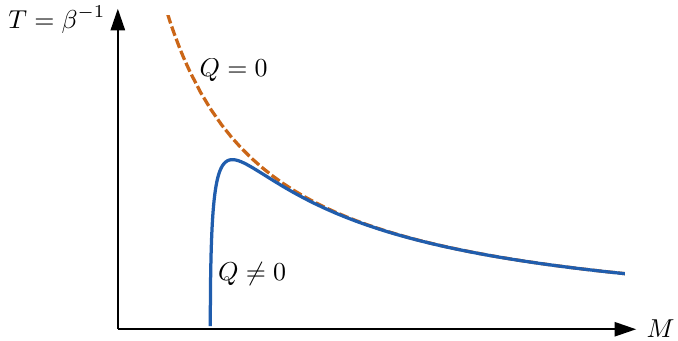
Figure 2 . Temperature vs. mass for a Schwarzschild (dashed line) and Reissner-Nordstr(cid:127)om (solid line) BH when r B . A BH carrying unscreened electric charge is always colder than its ! 1 uncharged